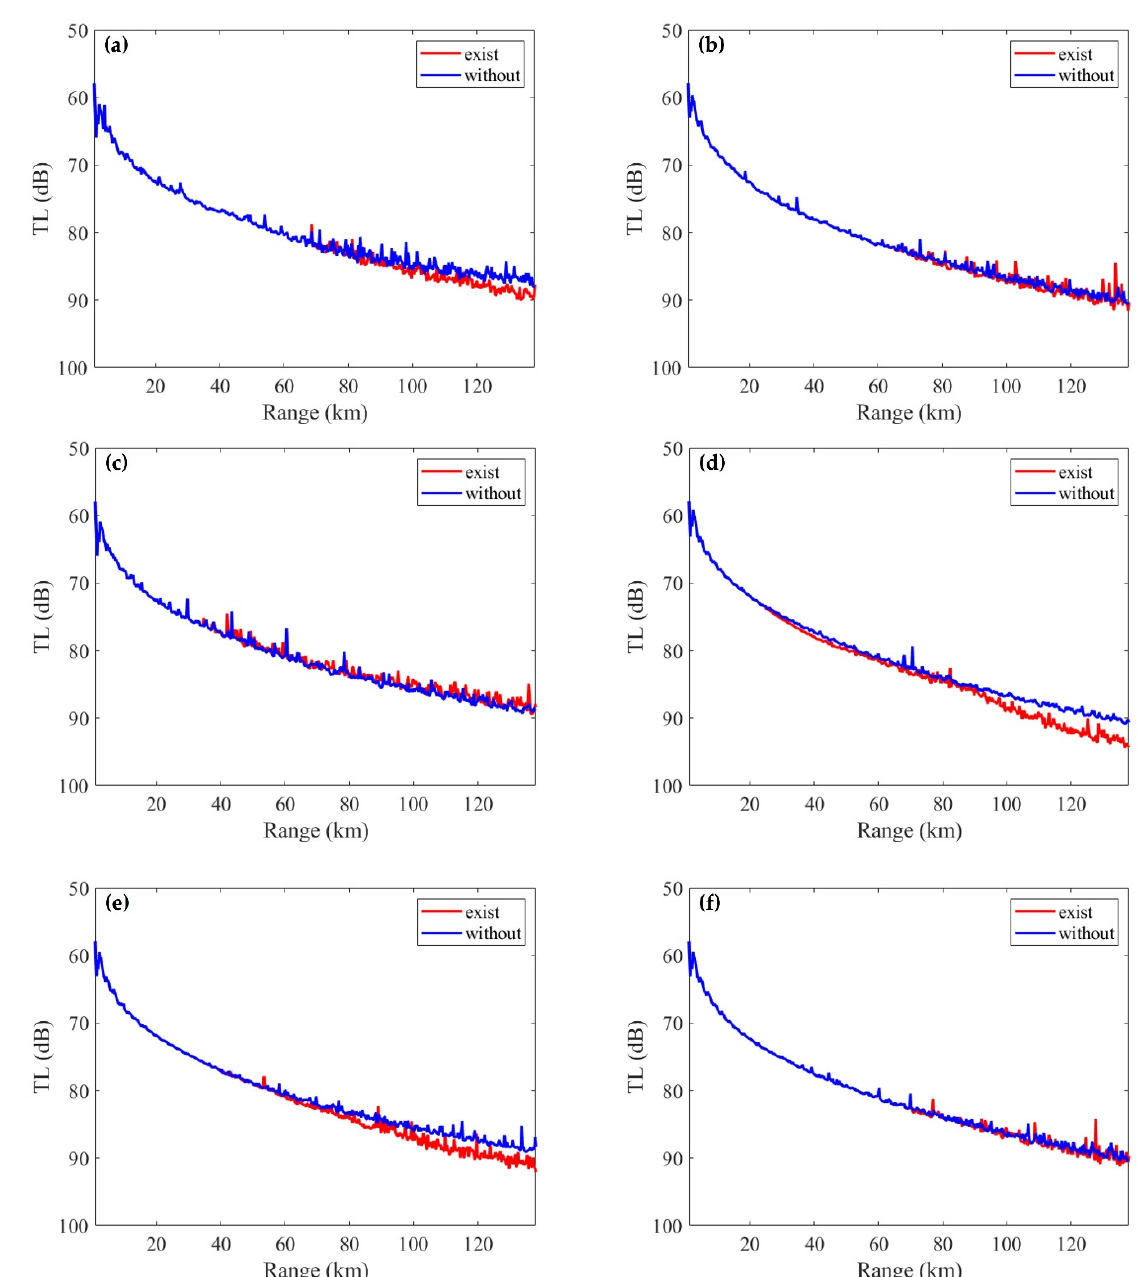
Figure 8. The comparison of the TL between the existing frontal zone and none at different sections and propagation directions (the depth range is 0–100 m): ( a ) 39.5° W, and the direction is 50.6°–51.6° N; ( b ) 39° W, and the direction is 50.6°–51.6° N; ( c ) 38.5° W, and the direction is 50.6°–51.6° N; ( d ) 39.5° W, and the direction is 51.6°–50.6° N; ( e ) 39° W, and the direction is 51.6°–50.6° N; ( f ) 38.5° W, and the direction is 51.6°–50.6° N. The iterative hierarchical clustering result (Figure 6a) meets the error standard range for the judgment of the starting point of the frontal zone at 0–100 m (11.2 km).